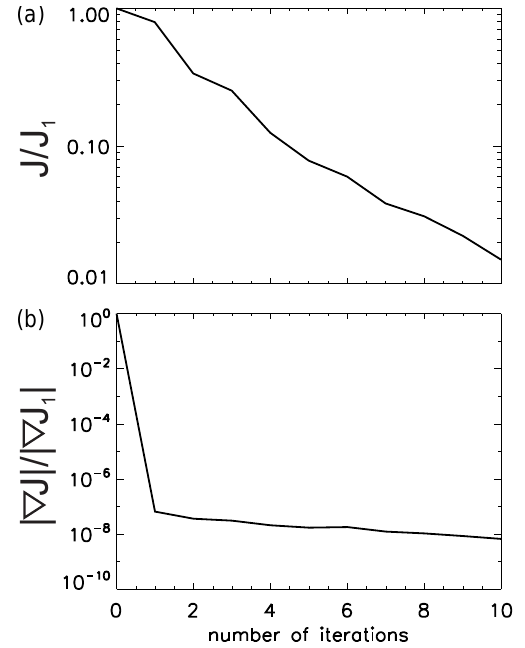
Fig. 8. (a) Normalised cost function reduction for INVICAT retrieval using pseudo SF 6 observations. Figure 8. (a) Normalised cost function reduction for INVICAT re- (b) Normalised cost function gradient development for the same experiment. trieval using pseudo SF 6 observations. (b) Normalised cost function gradient development for the same experiment. 42